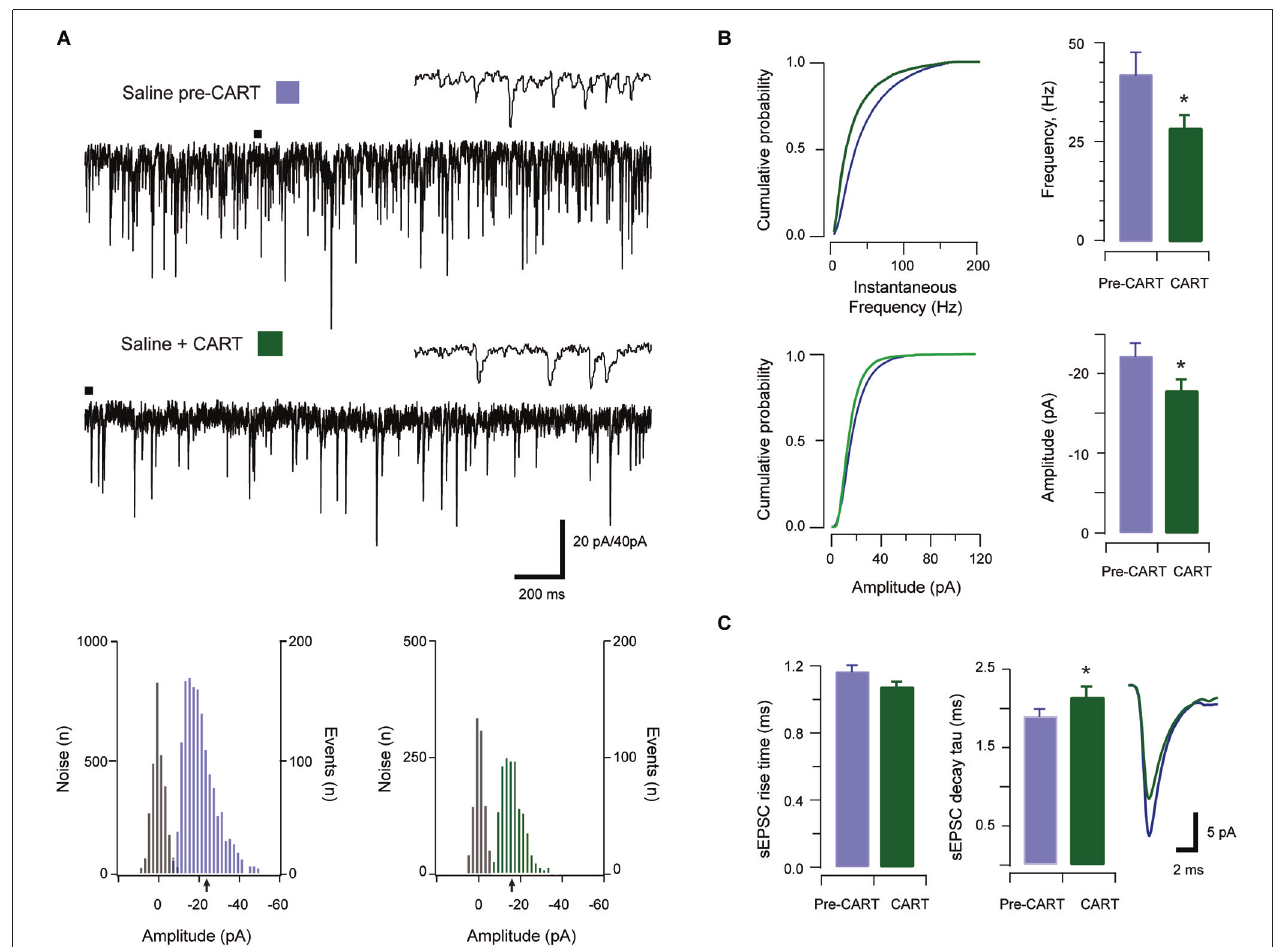
a significant reduction in both instantaneous frequency ( B, upper ) and amplitude ( B, lower ) of aPVT neurons in response to saline or cocaine. Group data plots ( C ) show sEPSC instantaneous frequency was reduced by CART ( * p = 0.002 ) , as was amplitude ( * p = 0.008 ) . In contrast, rise time was not affected by CART. Finally, decay time constant was significantly increased following CART (* p = 0.007, an average of 1387 events and 799 events were analyzed respectively) with representative traces of rise and decay time pre- and